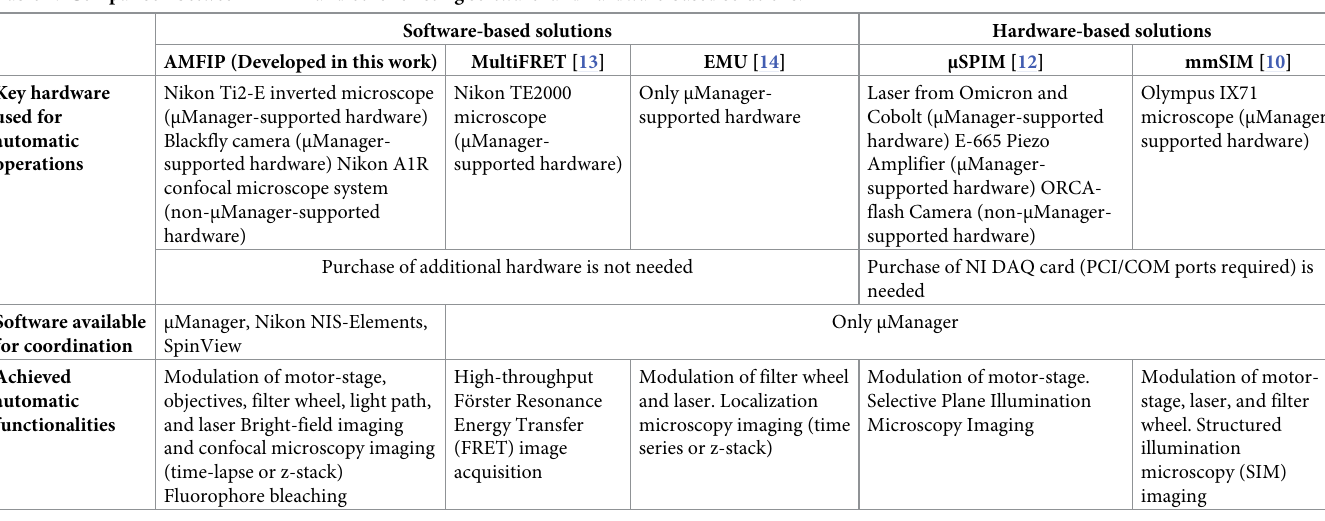
Table 1. Comparison between AMFIP and other existing software- and hardware-based